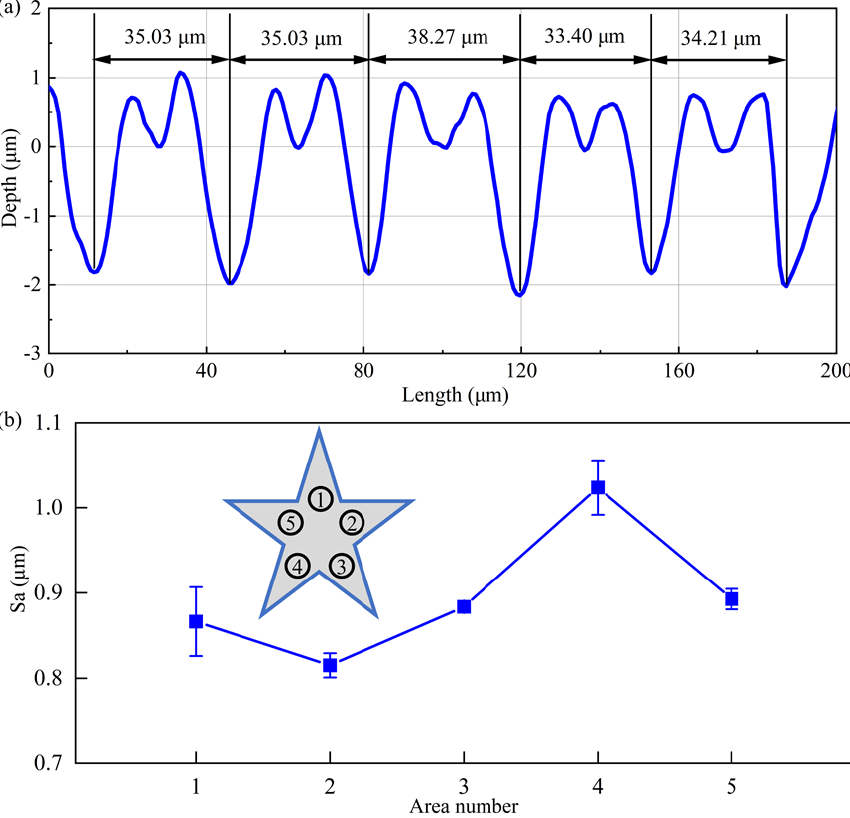
Figure 11. ( a ) Cross-sectional profile of fabricated grooves. ( b ) Surface roughness of five areas in the faricated pentagonal pattern. faricated pentagonal